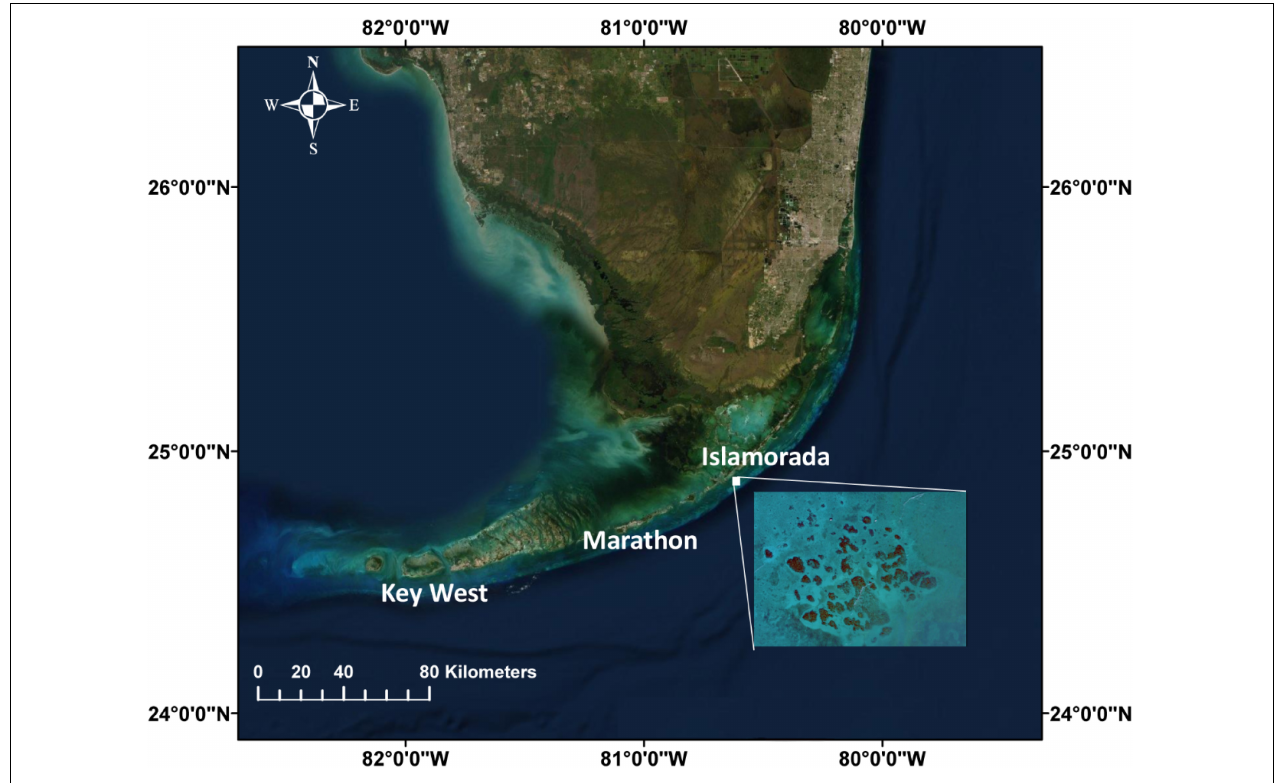
FIGURE 1 | Florida Keys (created using ArcMap) and inserted satellite imagery obtained from Google Earth showing Cheeca Rocks.